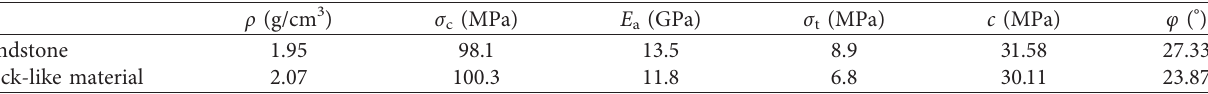
Figure 1: (a) XRD and (b) SEM results of sandstone in this research. Table 1: Physical and mechanical parameters of sandstone and rock-like material.